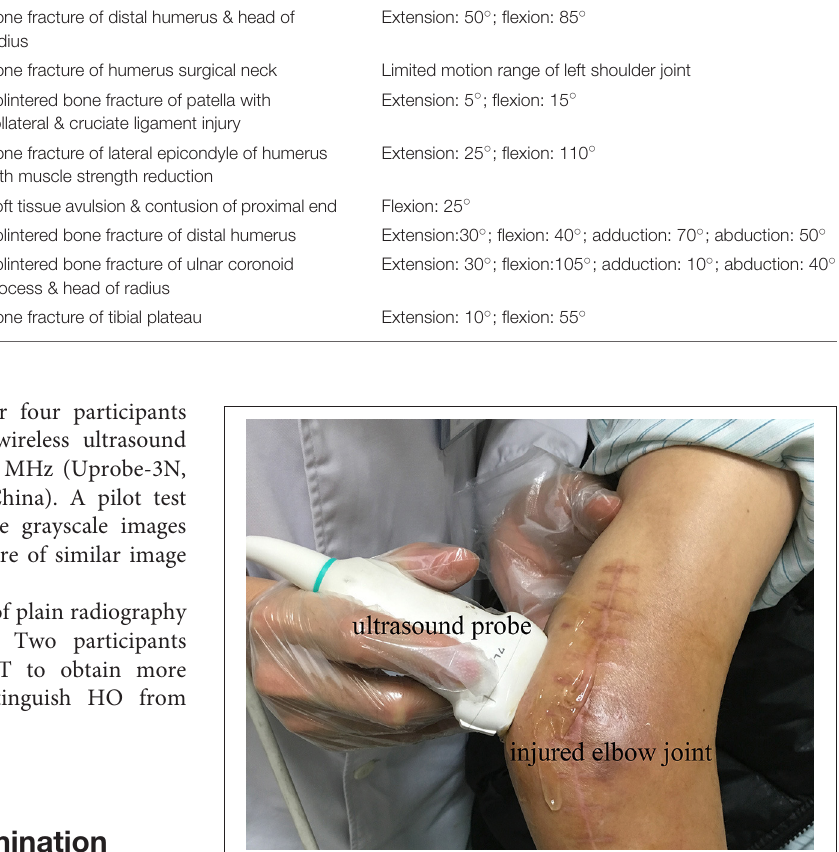
TABLE 1 | Background data of the participants. Participant No.